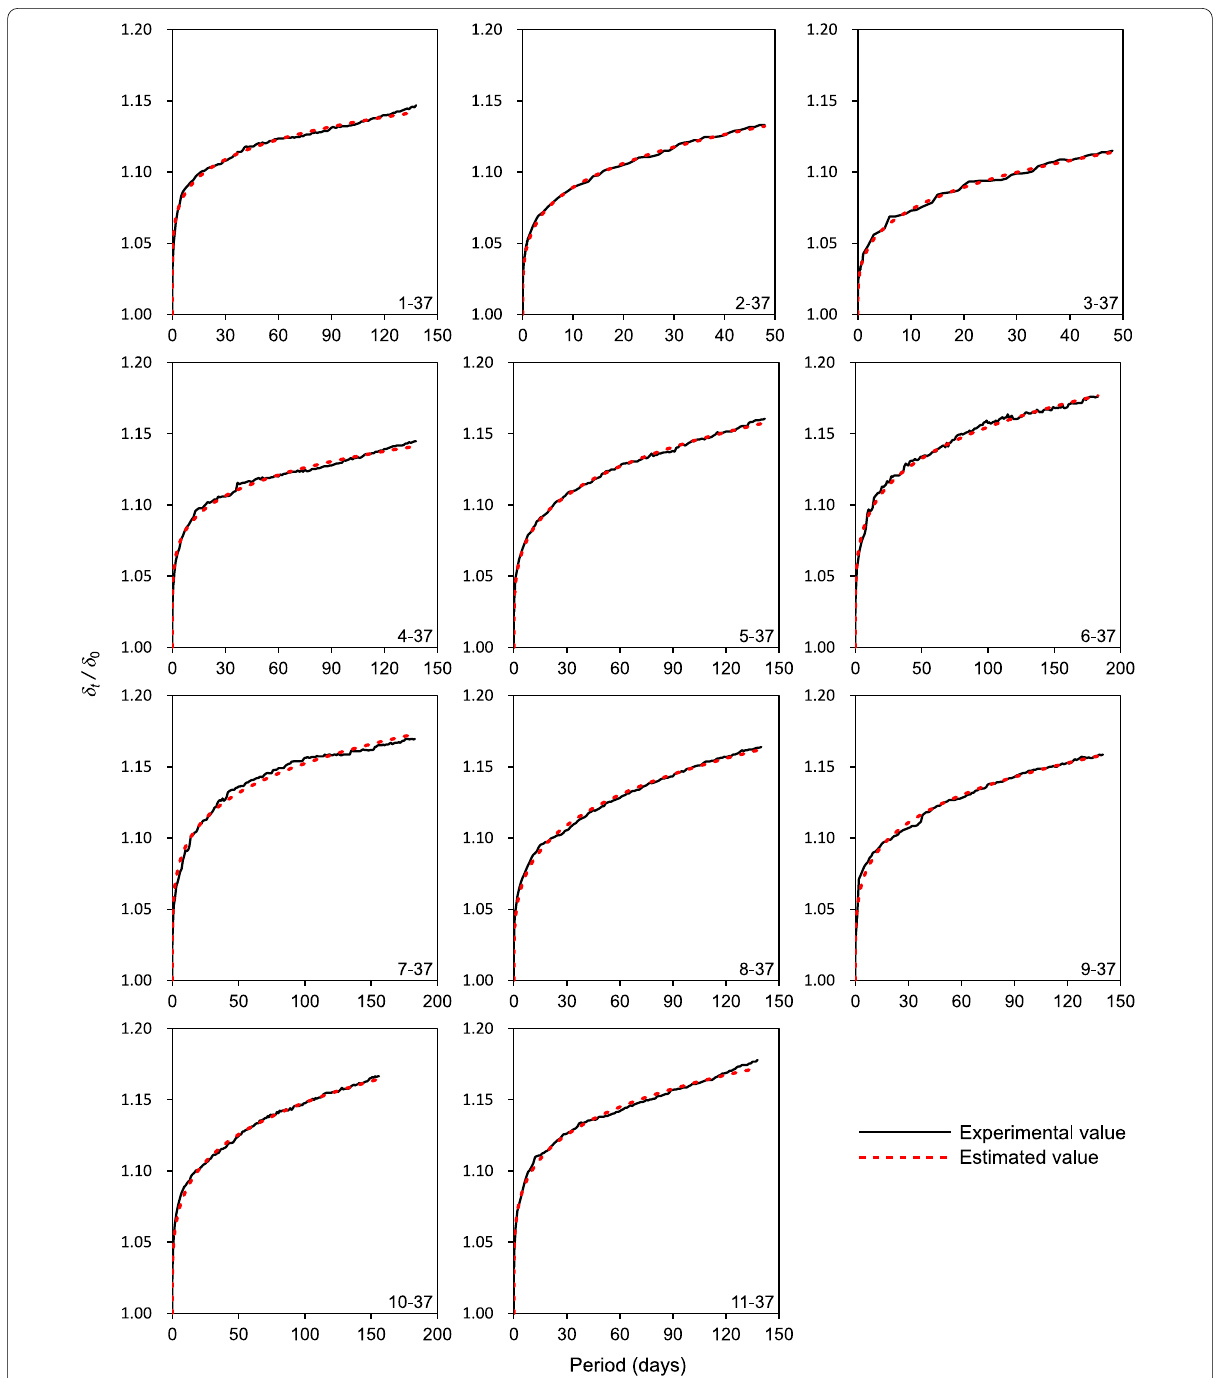
Fig. 6 Relationship between the test period and relative creep. δ t is deflection at time t and δ 0 is initial